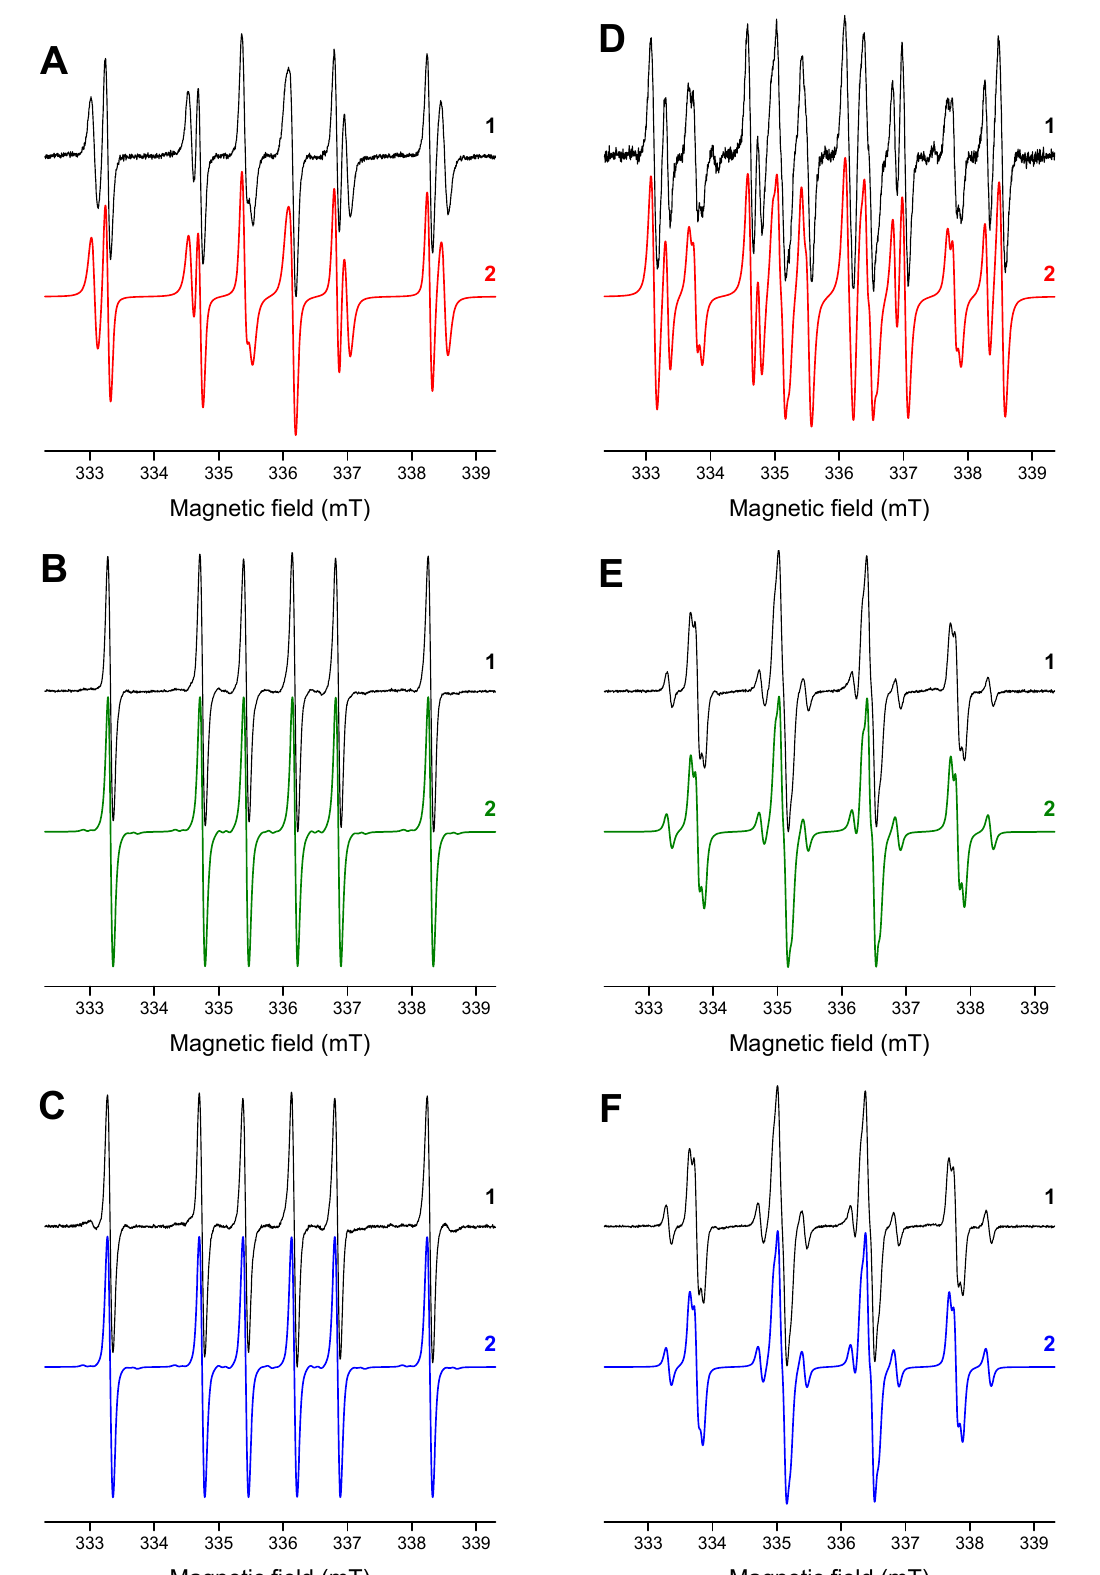
Figure 3. The normalized experimental (1) and simulated (2) EPR spectra obtained upon in situ LED@400 nm exposure of 2-substituted naphthoquinone derivatives in acetonitrile under argon in the presence of DMPO spin trap: ( A ) HNQ/Iod, ( B ) HNQA /Iod, ( C ) HNQE /Iod, ( D ) HNQ/Iod/TT, ( E ) HNQA /Iod/TT, and ( F ) HNQE /Iod/TT. Irradiation time: 450 s ( A – C ) and 225 s ( D – F ). Modulation amplitude of 0.025